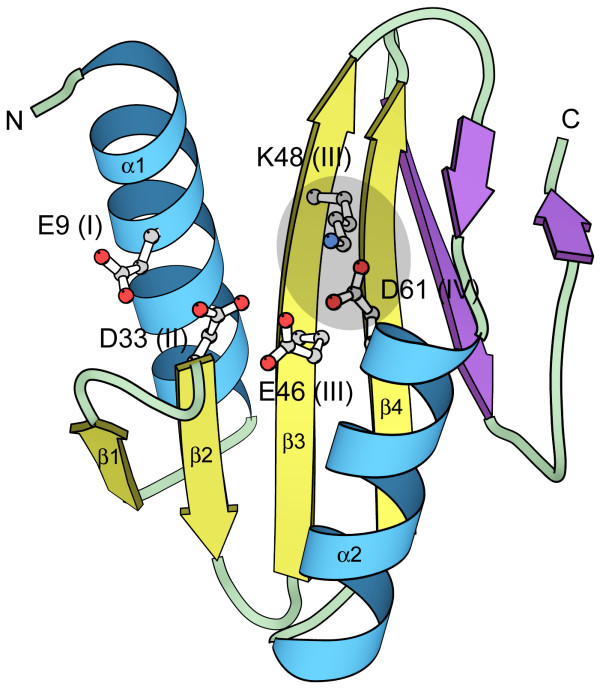
Typical PD-(D/E)XK nuclease structure. Ribbon representation for archaeal holliday junction resolvase (Hjc, pdb:1gef) with the critical motif I (E9), motif II (D33), motif III (E46, K48) and motif IV (D61) active site residues shown as balls-and-sticks. Secondary structure elements of the conserved core fold are labeled and colored blue (α-helix) and yellow (β-strand), while additional insertions to the core are colored violet. In several detected families, conserved motif III lysine migrates to motif IV where (frequently mutated to arginine) it may occupy a similar spatial position (highlighted in grey) and thus play an equivalent functional role.